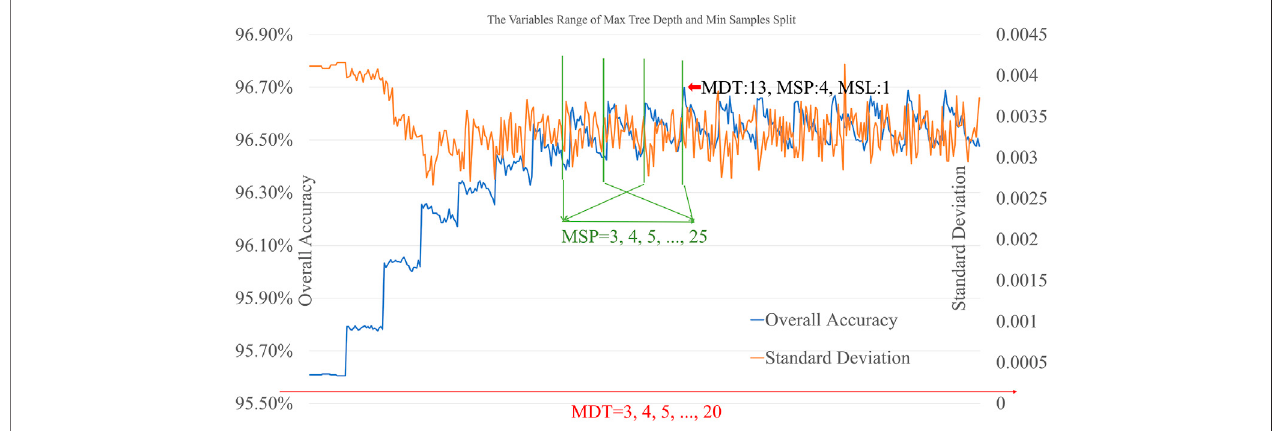
FIGURE 6 | Average accuracy and standard deviation for the variable range of maximum depth and minimum sample split. The range of MDT, MSP, and MSL are set from 3 to 20, 3 to 25, and 1, respectively.